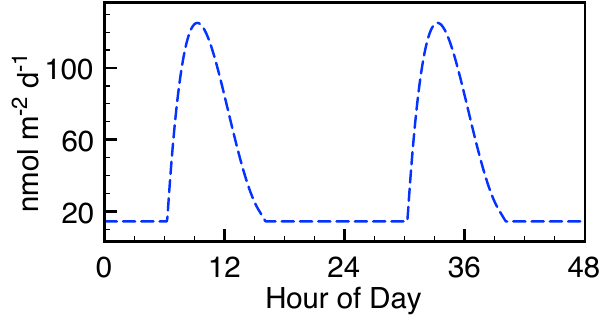
Fig. 6. Flux of I 2 added in PHOTO model